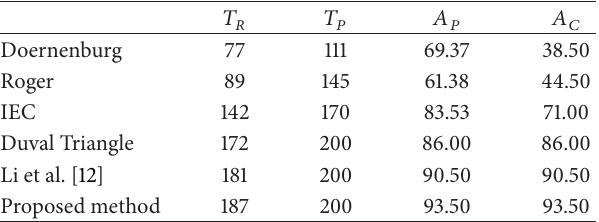
Table 3: Comparison of accuracy of different